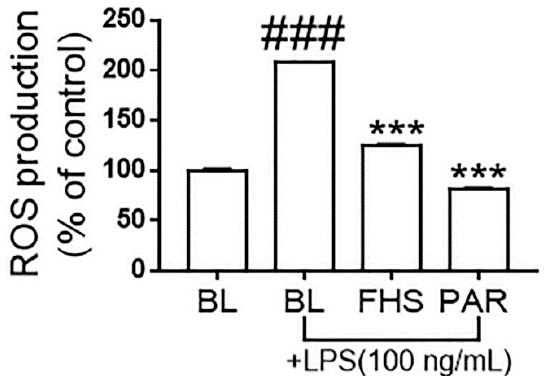
Figure 6. FHS suppressed ROS production. Cells were incubated with FHS for 1 h and then incubated with LPS for another 4 h. The value was calculated by dividing with control ( n = 3). BL, medium without the addition of extracts; FHS, fermented hemp seed-containing medium’s supernatant of Day 7. ### p < 0.001 vs. the control group; *** p < 0.001 vs. the LPS-treated group.